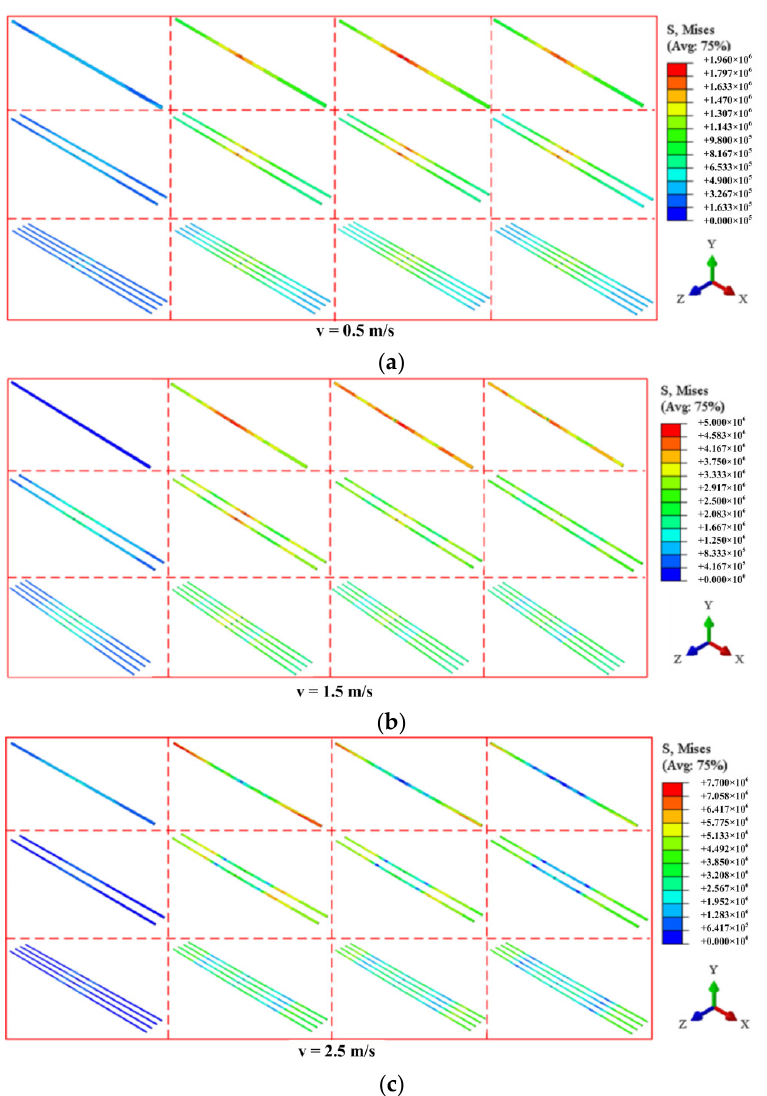
Figure 20. The stress trend of bonding layer when impact velocity is ( a ) 0.5 m/s; ( b ) 1.5 m/s and ( c ) 2.5 m/s.